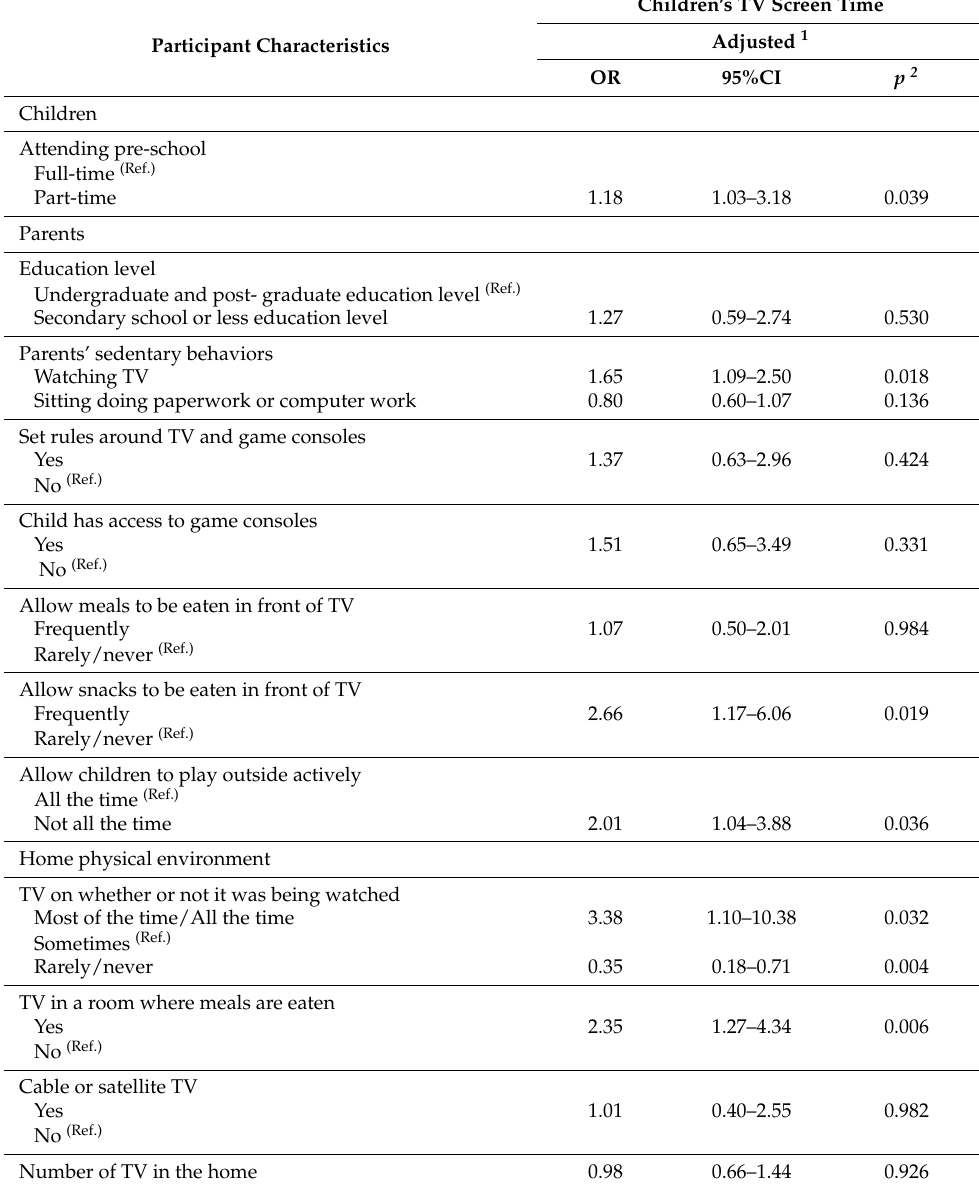
Table 4. Association between participant characteristics, home environment and children’s TV screen